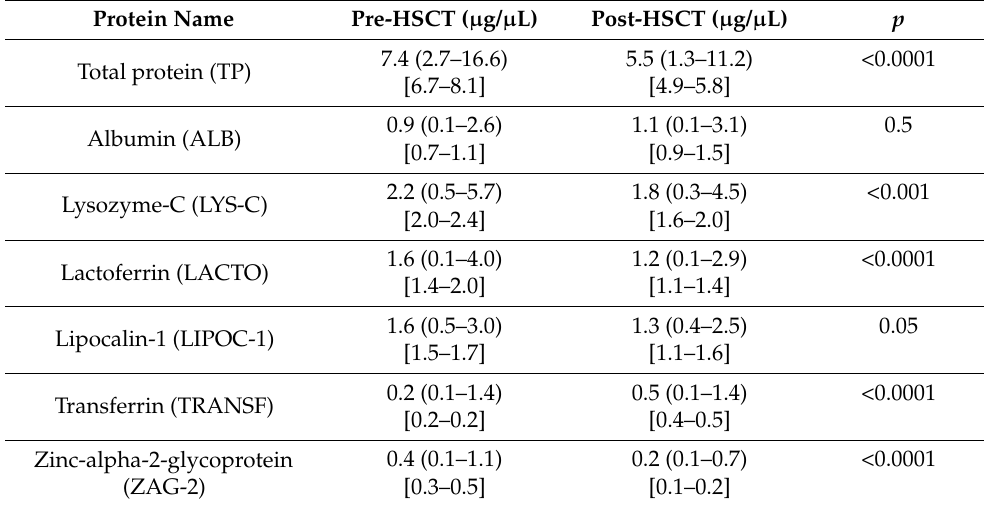
Table 3. Levels of tear proteins analyzed in patients pre- and post-hemopoietic stem cell transplant (HSCT). Data are expressed as median (min-max) [95%